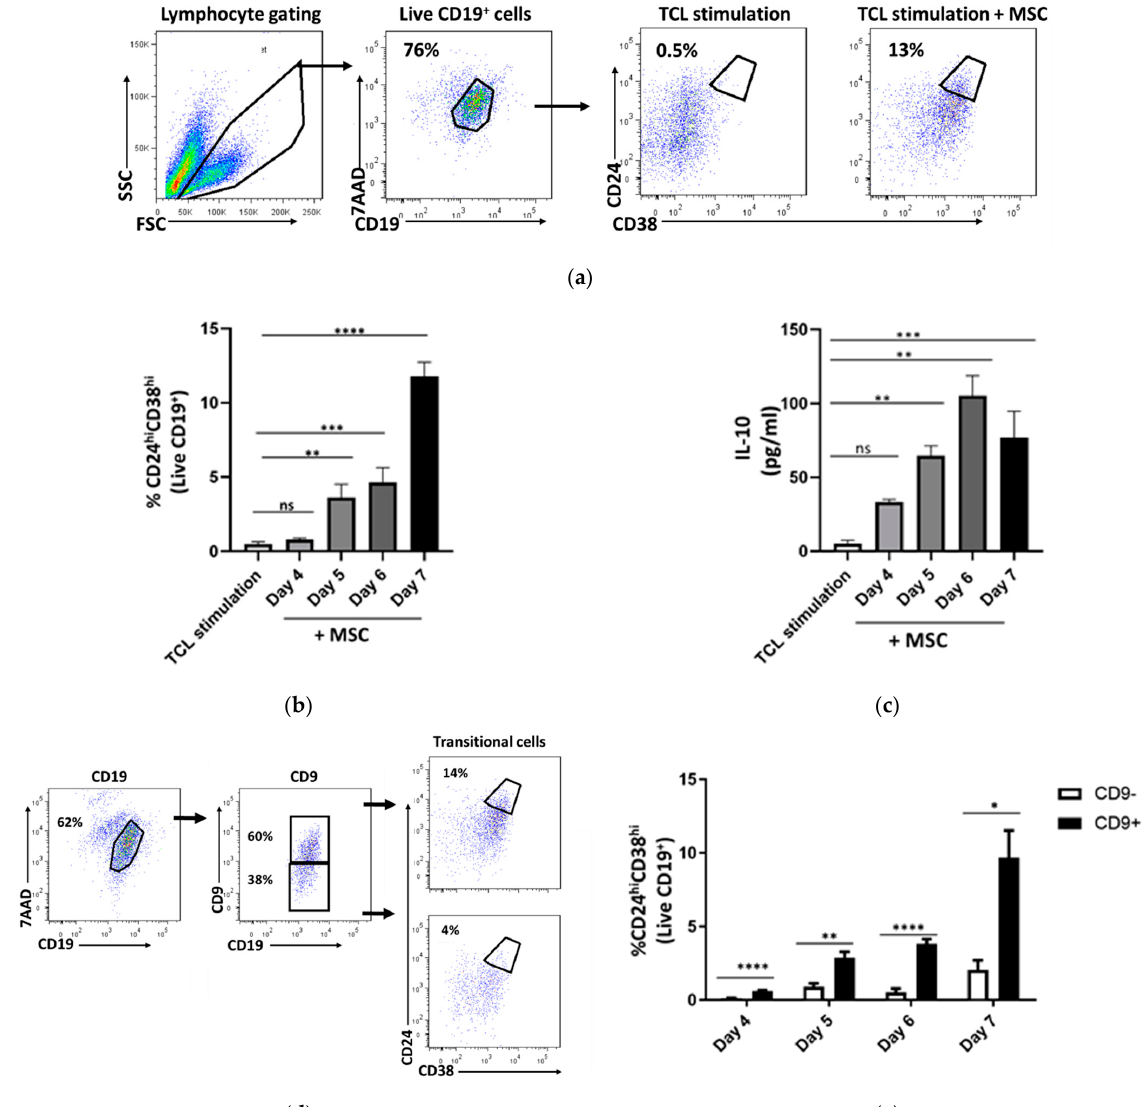
Figure 2. Transitional Breg cells are enriched within CD9-positive B cells. Naïve B cells were purified and activated with T-cell like (TCL) stimulation, in the presence of mesenchymal stem cells (MSC) for 7 days for the optimum induction of CD24 hi CD38 hi transitional B cells. TCL stimulation without MSC serves as a control. ( a ) Flow cytometry gating strategy for analyzing transitional B cells. ( b ) Significant time-dependent increase of transitional B cells upon TCL stimulation with MSC. ( c ) Significant time-dependent increase of IL-10 in the culture supernatant upon TCL stimulation with MSC as measured by ELISA. ( d ) Representative gating strategy for the analysis of transitional B cells within CD9 - and CD9 + B cells. ( e ) Significant time-dependent increase of transitional B cell induction within CD9 + as compared to CD9 - B cells. Data show at least three independent experiments in each group. Error bars represent SEM; ns (non-significant) p > 0.05, * p < 0.05, ** p < 0.01, *** p < 0.001, **** p < 0.0001. Two-way ANOVA was performed to determine statistical significance.